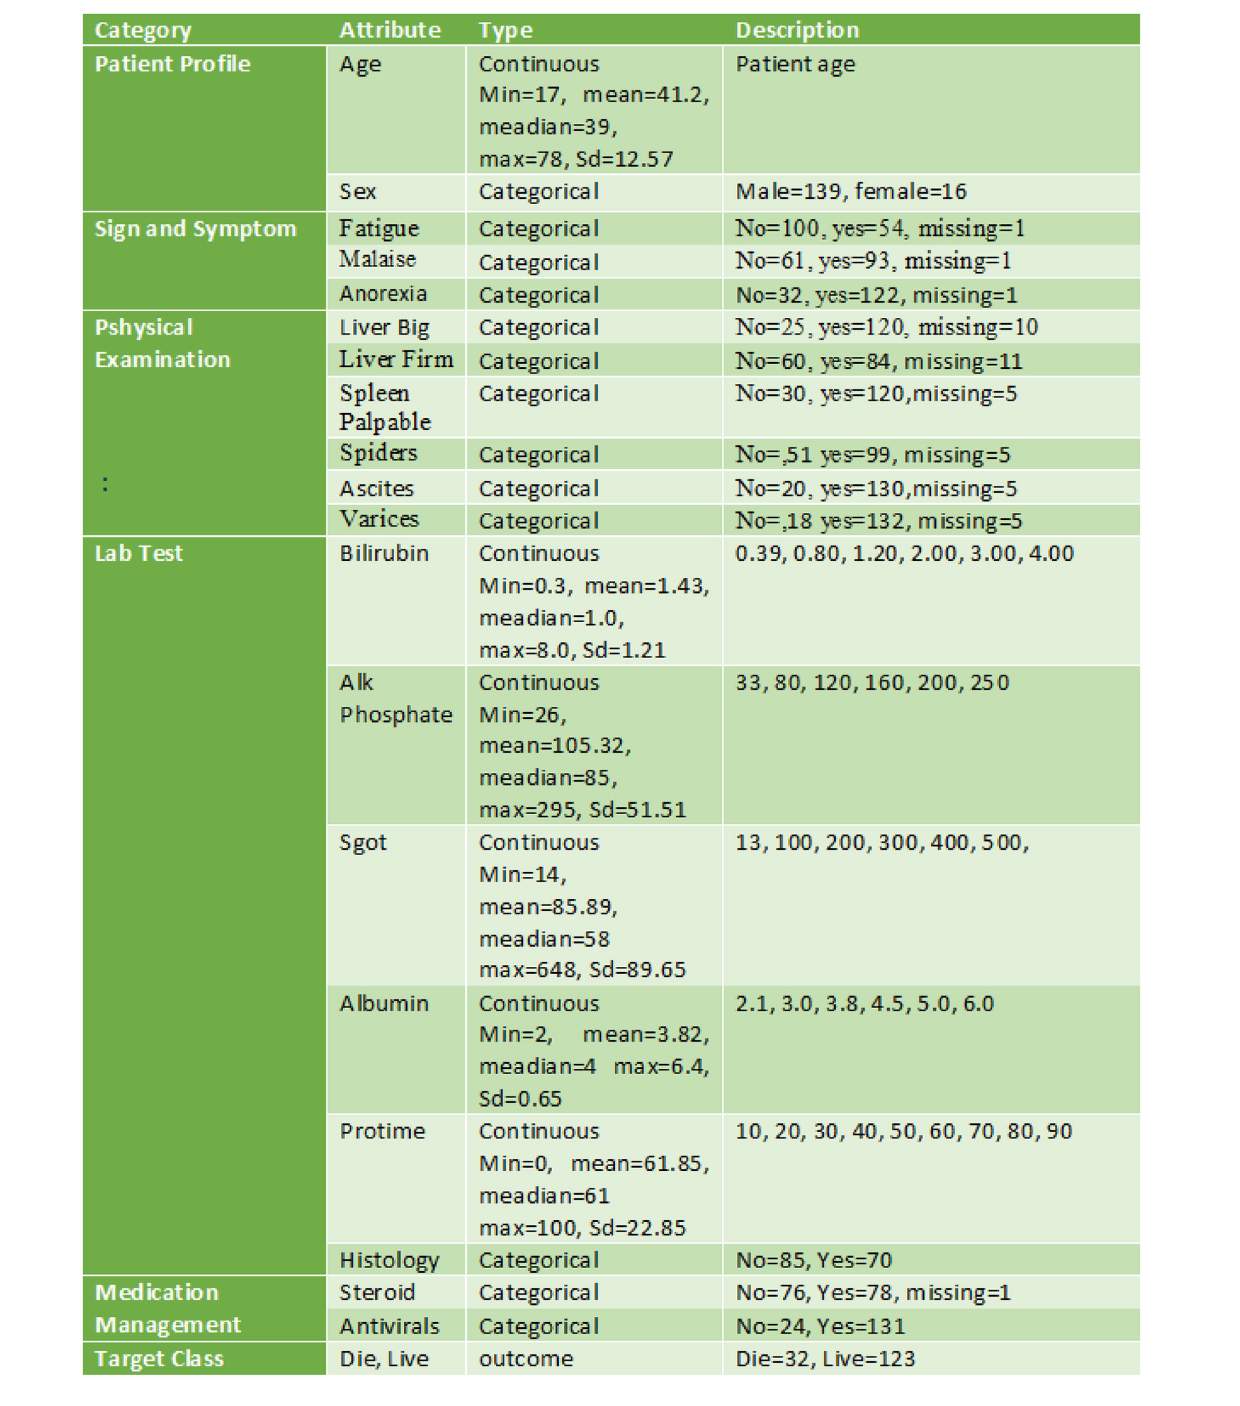
FIGURE 2 | Hepatitis dataset